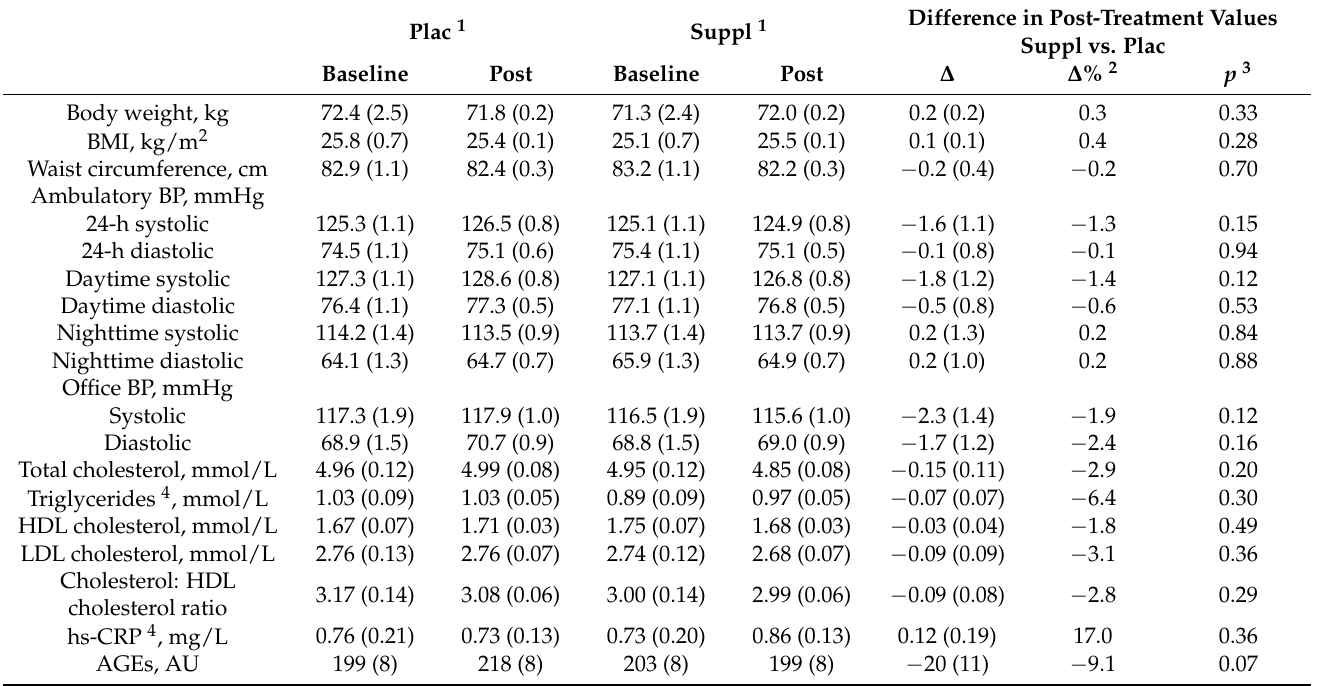
Table 2. Anthropometric measures and cardiometabolic risk factors in adults with prehypertension supplemented for 6 weeks with a placebo (Plac) or a polyphenol extract and L-citrulline supplement (Suppl) ( n = 69) 1